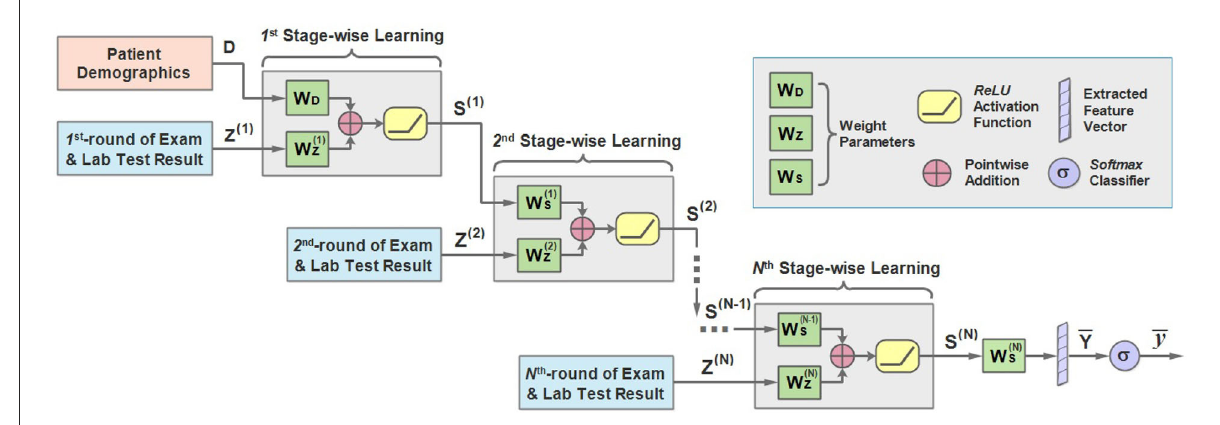
FIGURE3 An illustration of the architecture of the sequential stage-wise learning of the MMDL model.